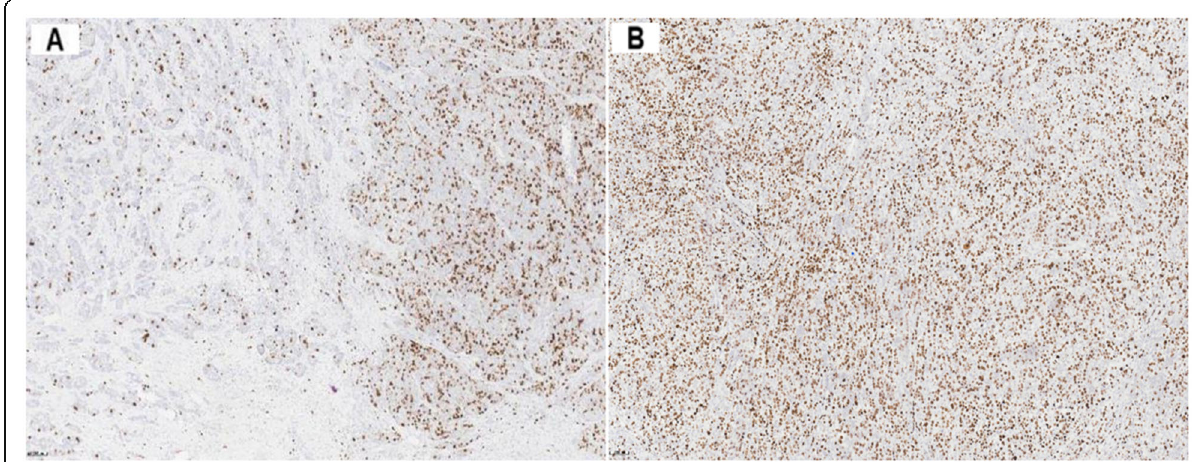
Fig. 5 Distribution of breast cancer Ki-67 positive tumor cells (10×). A: Breast cancer Ki-67 positive tumor cells are unevenly distributed, which is heterogeneous. The percentage of Ki-67 positive tumor cells on the left is lower than that on the right (hot spot); B: Ki-67 positive tumor cells of breast cancer are uniformly distributed, showing homogeneity